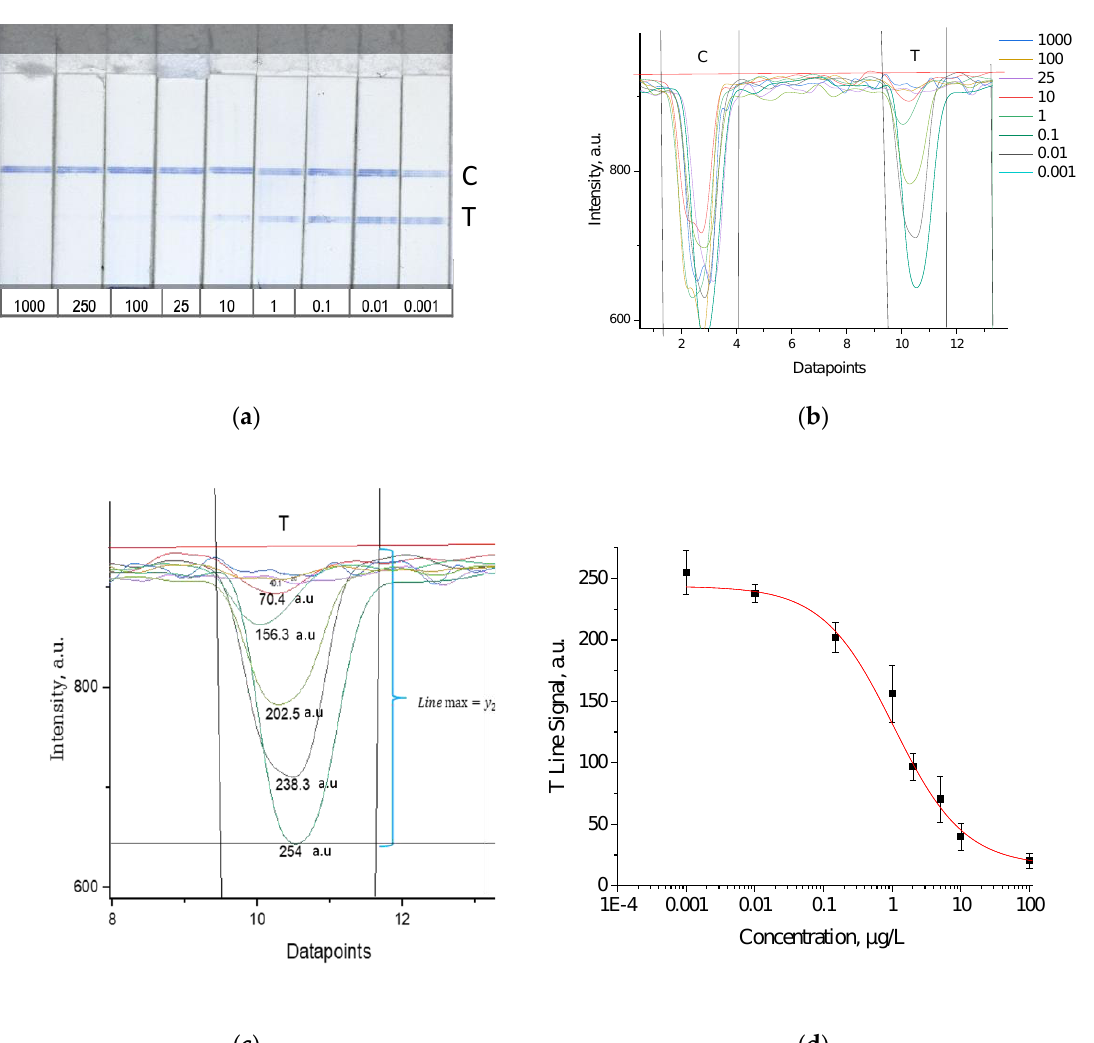
Figure 2. ( a ) Test strips with different concentration of BPA (in µg/L); ( b ) intensity profile of a test and control line and different concentrations of BPA; ( c ) evaluation of different test (T) line signals and baseline correction. The red horizontal line is the baseline for all signals (y 2 ). The black horizontal line (at y 1 ) is the example for concentration 0.001 µg/L (the maximal intensity (darkest) line, “Line max”, with the deepest intensity dip), the T Line Signal calculated as indicated by subtraction of the intensity values y 2 – y 1 = 254 a.u. ( d ) Calibration curve obtained by plotting the mean of 3 replicates (n = 3) against BPA calibrator concentrations. The standard deviation (SD) was calculated from the replicates and is shown as error bars.